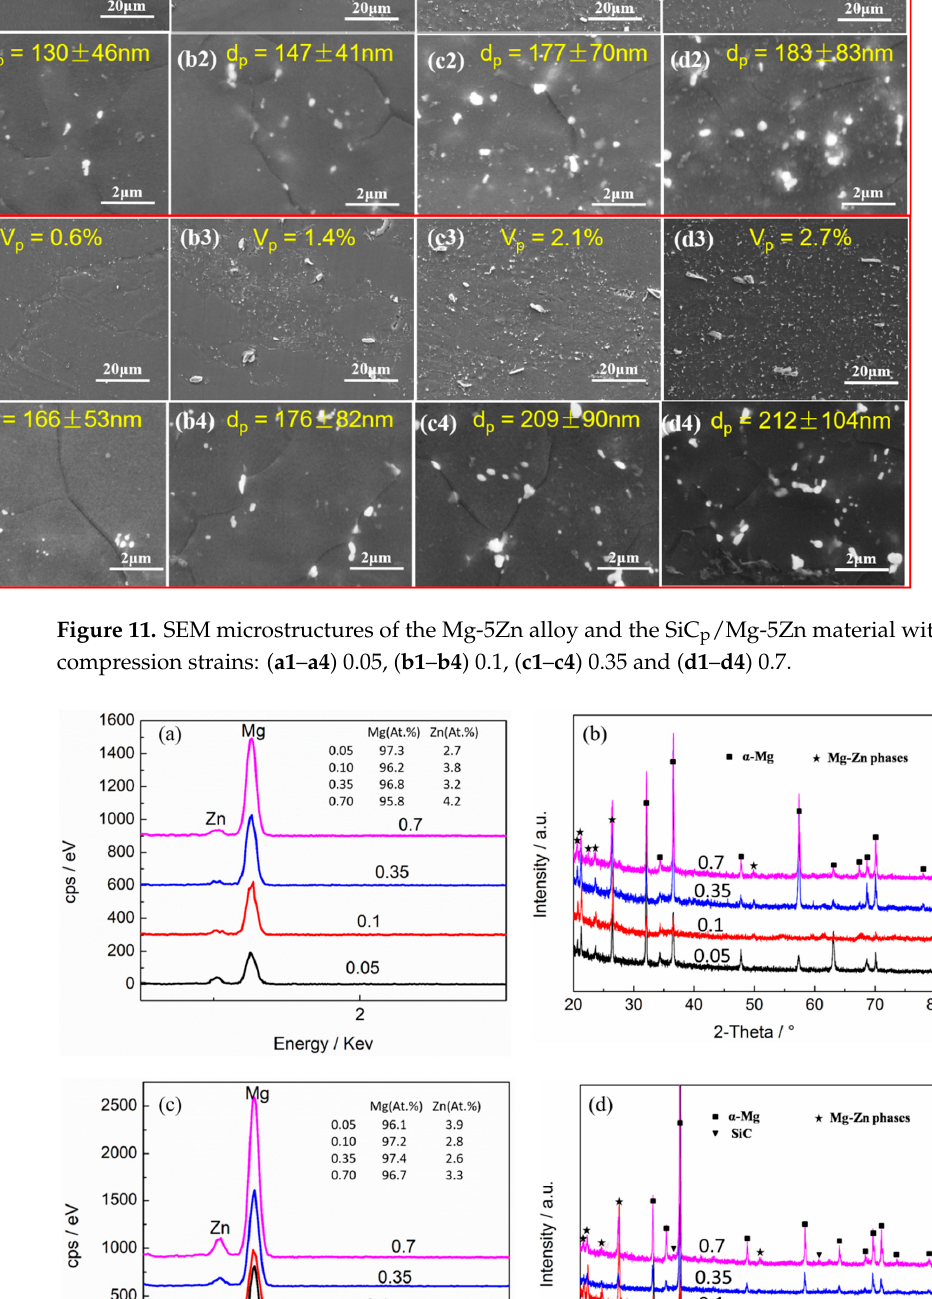
Figure 13. ( a ) Bright field image, ( b ) HRTEM map and ( c ) diffraction pattern of the precipitate in the Mg-5Zn alloy with a compression strain of 0.1. When the compression strain increased to ~0.35 and ~0.7, the improvement of the energy storage in Mg-5Zn alloy promoted the occurrence of DRX, which further increased the number of the grain boundaries. Thus, the size and volume fraction of the secondary phase in Mg-5Zn alloy increased with the increment of the compression strain. The aver- age size of Mg-Zn phase was ~177 nm and ~183 nm, respectively, and the volume fraction was ~1.3% and ~1.6%, when the compression strain was ~0.35 and ~0.7. Similar to the Mg-5Zn alloy, the SiC p /Mg-5Zn material also had an obvious secondary phase after compression, and the secondary phase was also distributed along the grain